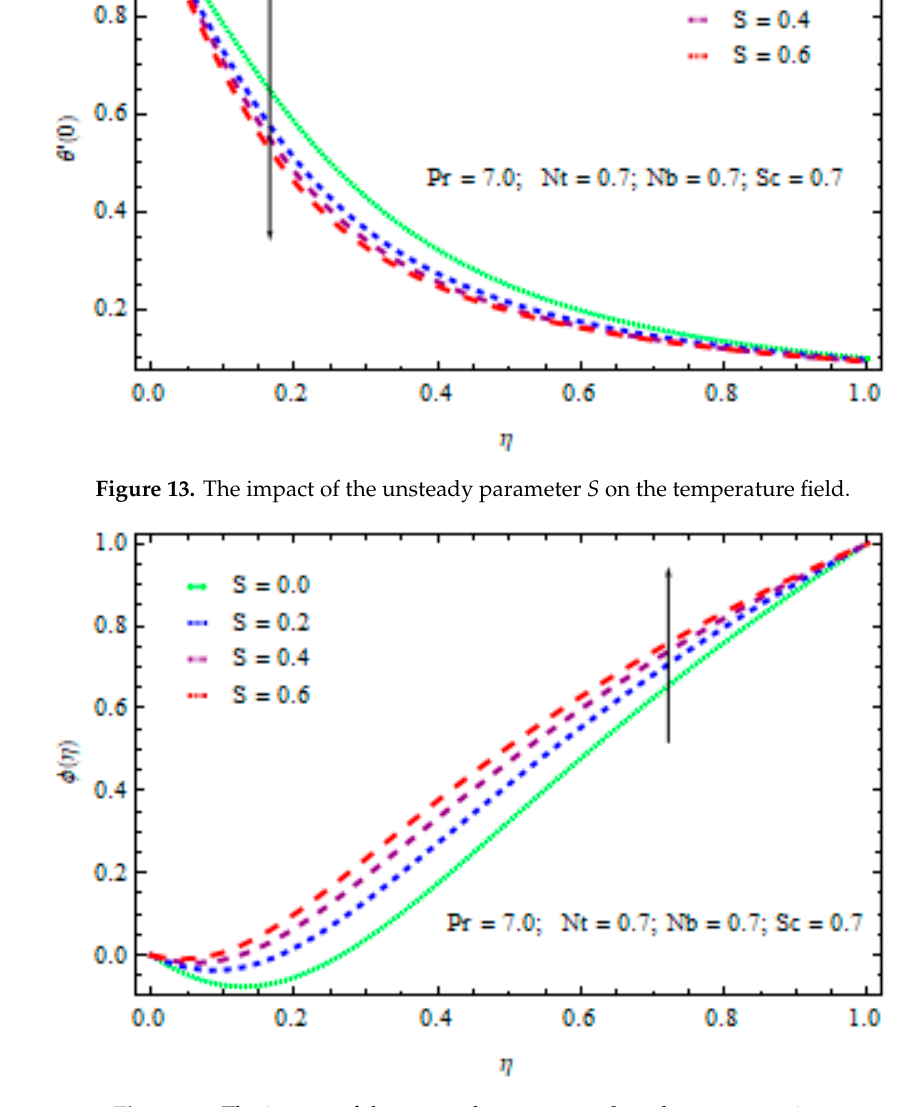
Figure 14. The impact of the unsteady parameter S on the concentration.